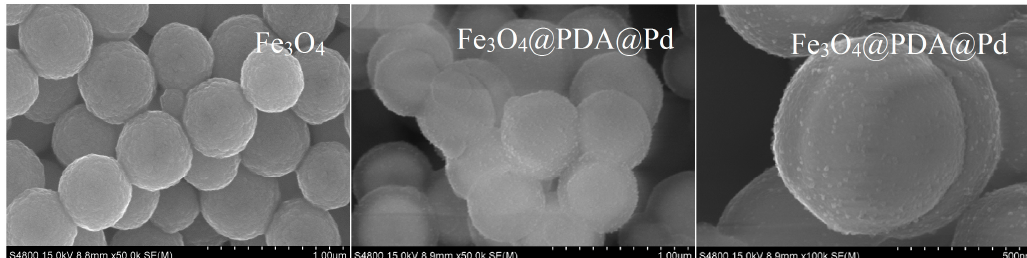
Figure 1. SEM images of Fe 3 O 4 and Fe 3 O 4 @PDA@Pd.